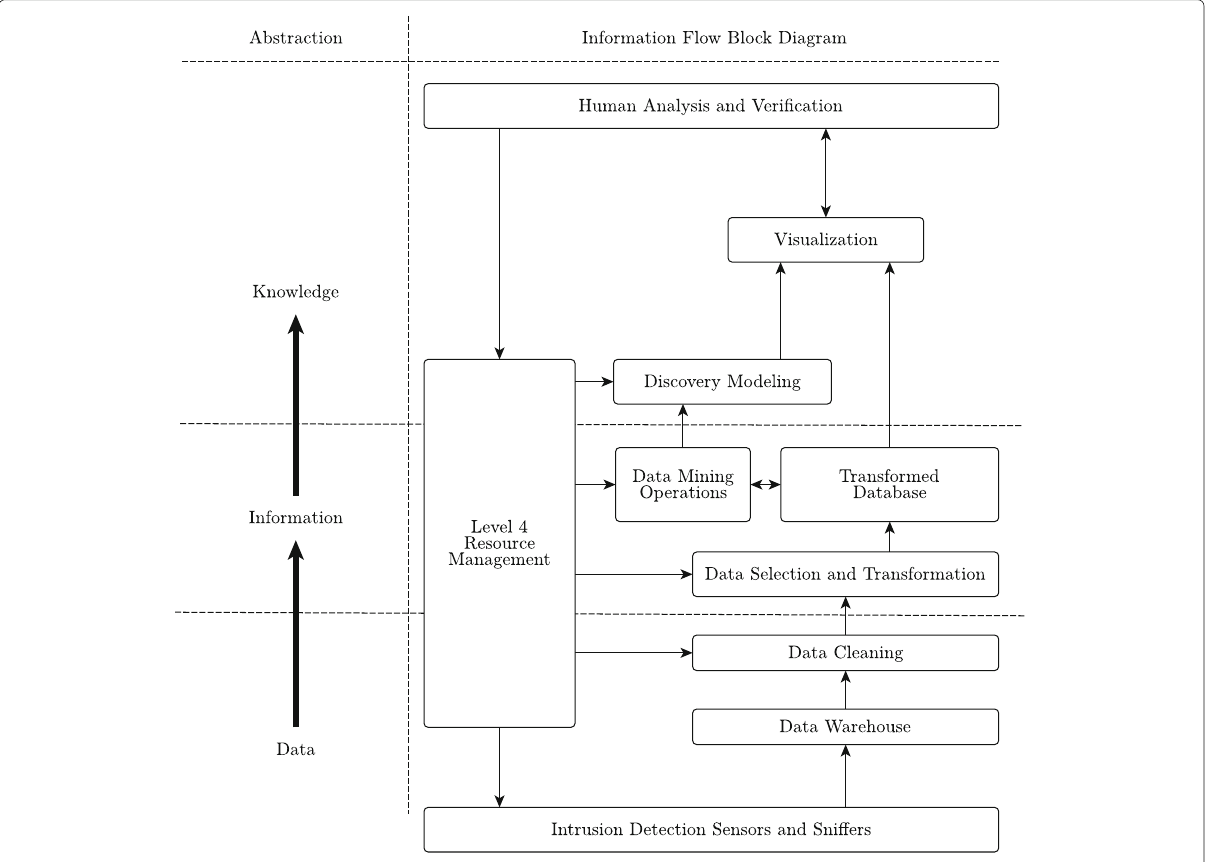
Fig. 13 Information flow for intrusion detection data mining